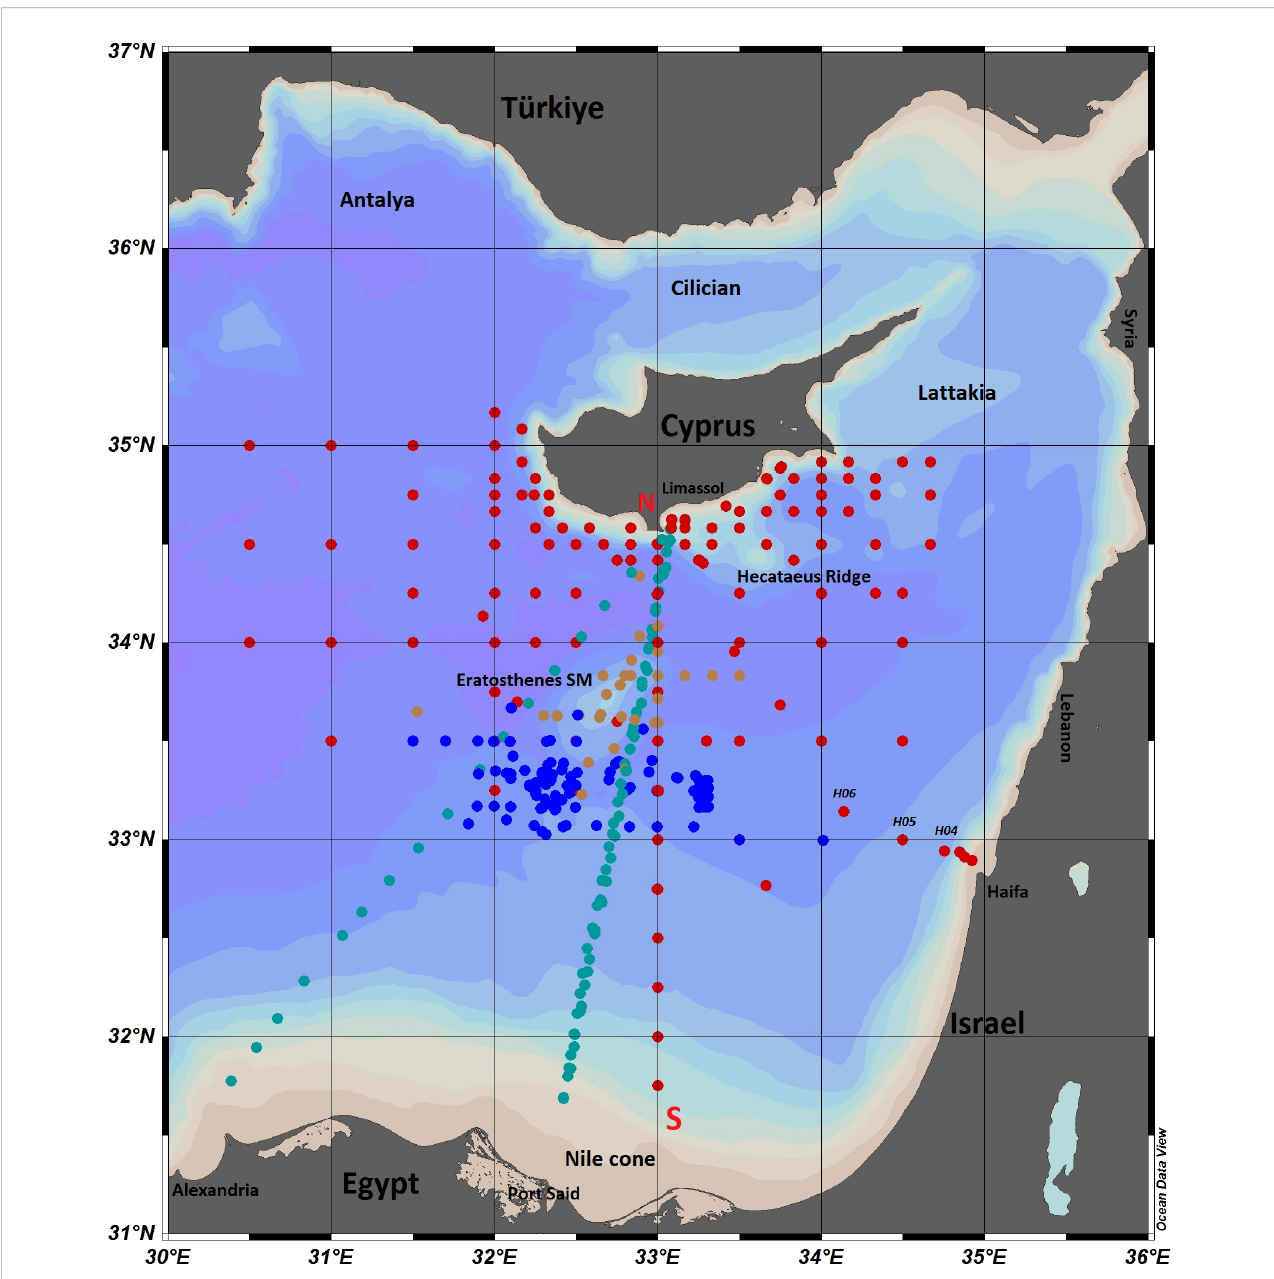
FIGURE 1 Physiography of the eastern Levantine Basin and locations of the CTD stations in the SE Levantine gathered during the CYBO and HaiSec (red dots), CYCLOPS (blue dots) and MSM14-1 (light brown dots) research cruises, and the XBT stations during the MFSPP-VOS and MFSTEP-VOS (light green) transects along Limassol (Cyprus) - Port Said (Egypt) and Limassol – Alexandria (Egypt). Stations H04-H06 across the Israeli shelf are also